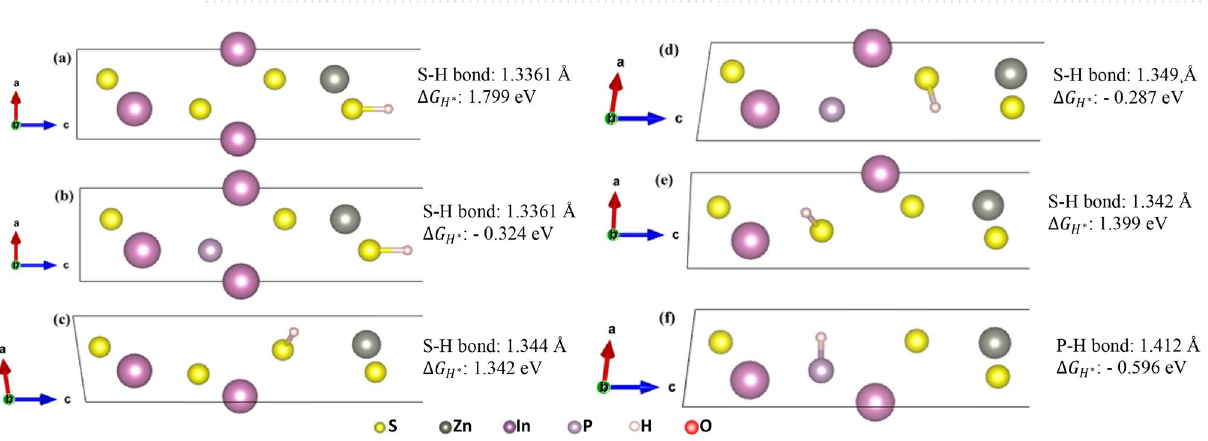
Figure 5. Water molecule interaction with ( a ) In2 from ZIS (110), ( b ) In2 from P-ZIS (110), and ( c ) P from P-ZIS (100). For ease of visualization, only interactive O bonding is shown.